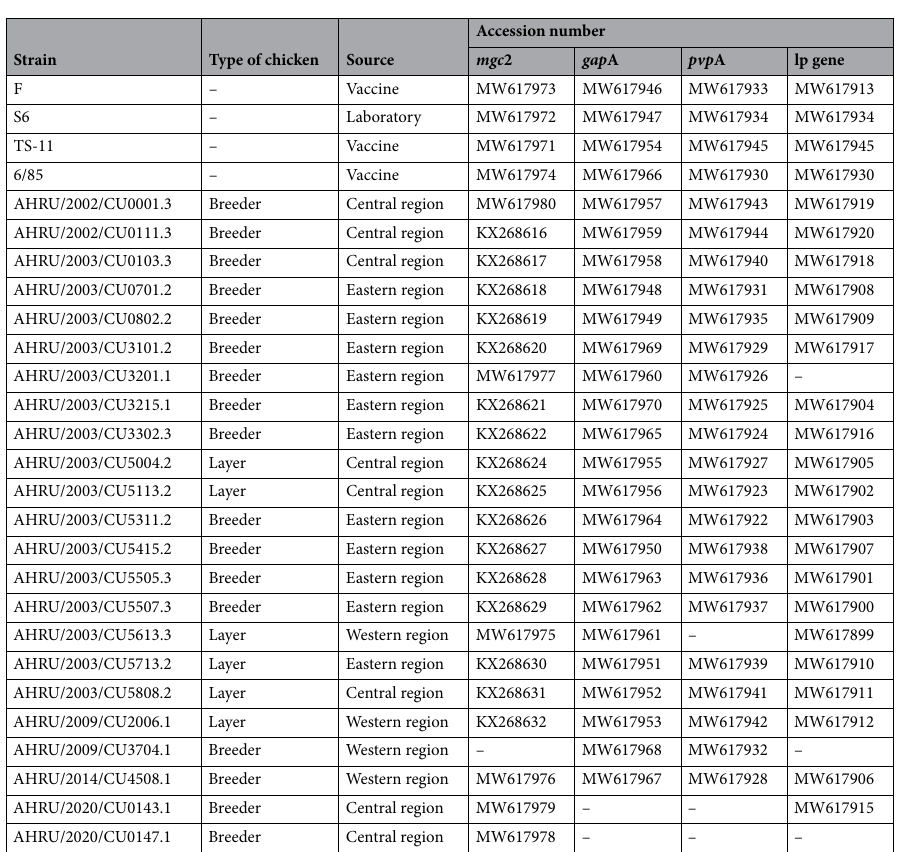
Table 3. Thai MG strains and GenBank accession